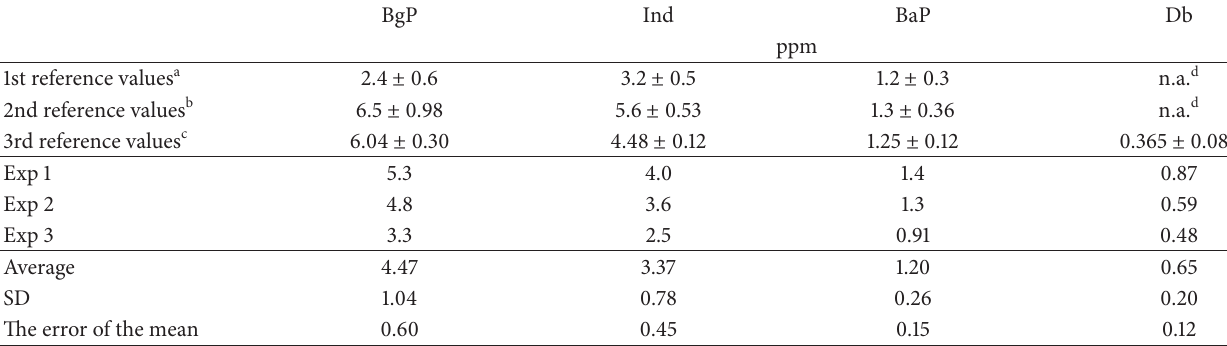
Table 5: Results of measurement test with SRM 1650 diesel particulate matter.